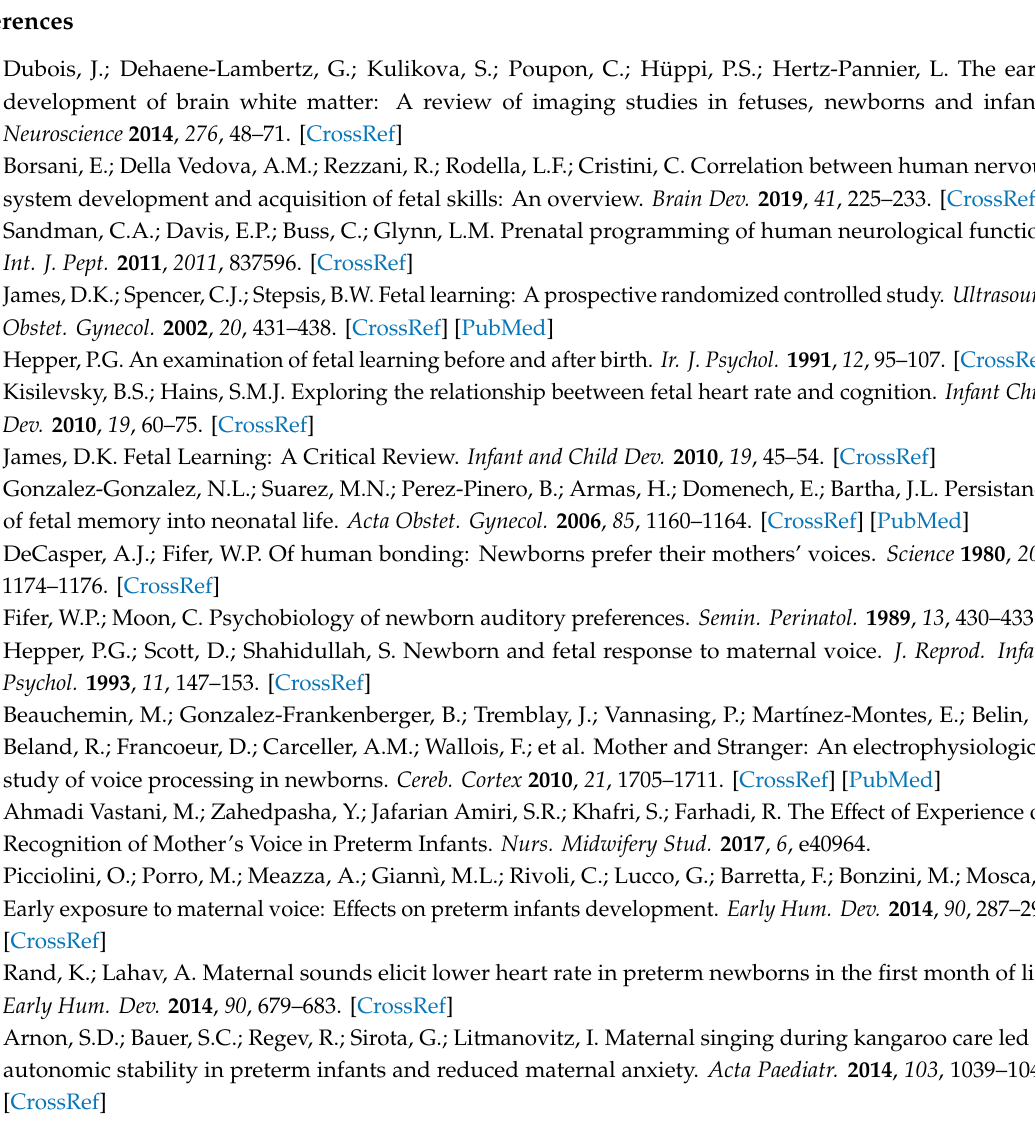
Figure S1: Temporal clusters for speech-envelope coupling analysis; Figure S2: Orienting response (0–10 s) to rhyme and voice familiarity; Figure S3: Stimulation response (0–180 s) to rhyme and voice familiarity; Figure S4: Individual stimulation response (0–180 s) to voices; Figure S5: Orienting response to nature of rhyme and voice; Figure S6: Overall change in HR to nature of rhyme and voice; Table S1: Means and standard deviations for voice / rhyme stimuli in di ff erent frequency